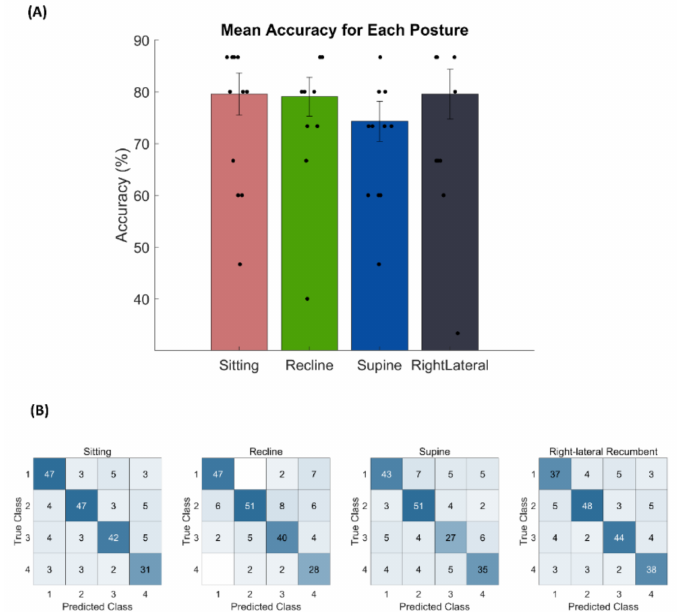
Figure 2. ( A ) The mean accuracy of online BCI control for each posture: sitting, recline, supine, and right lateral recumbent posture. The vertical black line denotes the standard error of the mean. The single dot represents the accuracy for each subject in each posture. ( B ) The confusion matrix for all subjects in each posture. It has 4-class for true and predicted class, which interprets as the number of selected targets for classifier and expected targets for each class, respectively. The blue color highlighted the number of targets.